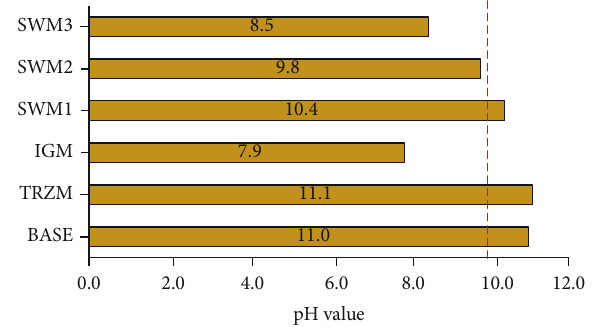
Figure 5: pH values of the di ff erent muds formulated in this